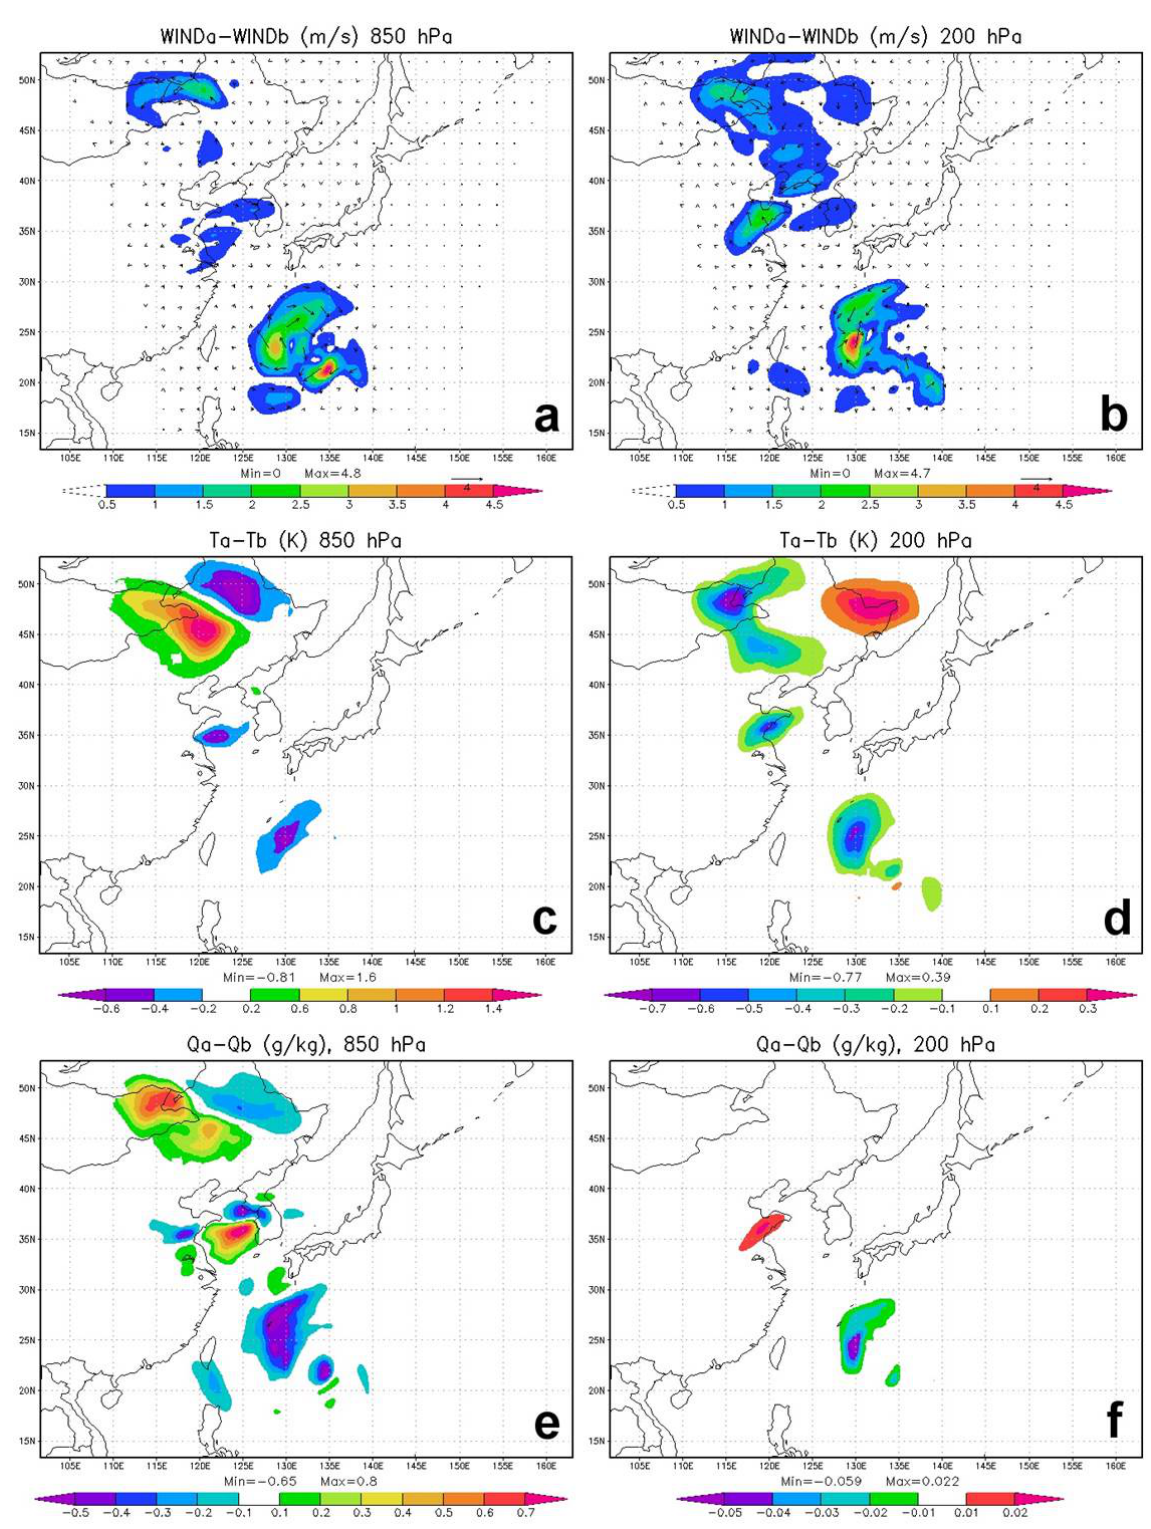
Figure 5. Same as in Fig. 3 except for analysis increment ( x a − x b ) of atmospheric variables in response to total column O 3 . Units are ms − 1 for wind, K for temperature and gkg − 1 for water vapor mixing